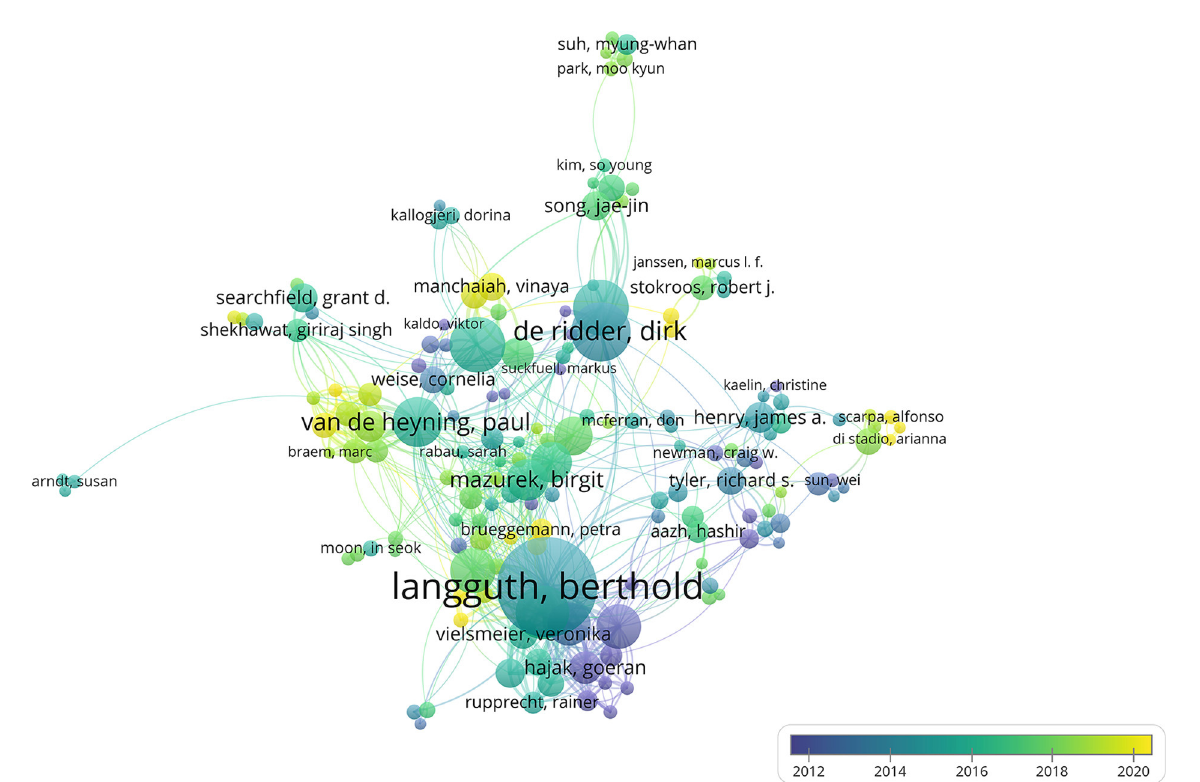
FIGURE6 The font size of each author’s name represents the number of articles. The thickness of the curved connecting line represents the collaborative intensity between authors; the authors collaboration network of research on tinnitus treatment; different colors inside the circle represent different time